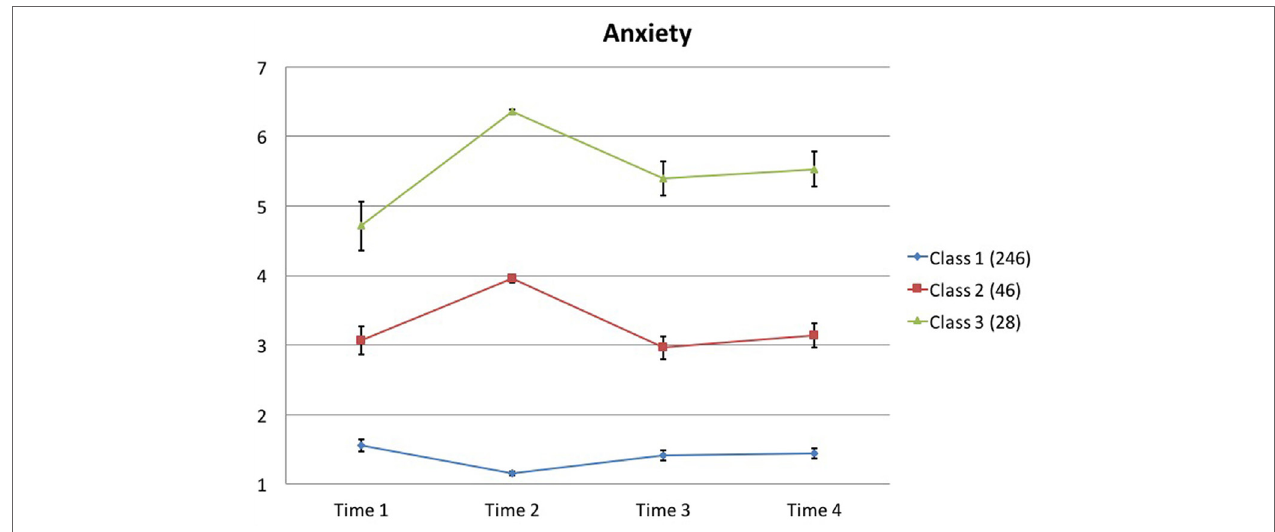
FigUre 1 | Latent profiles of anxiety.